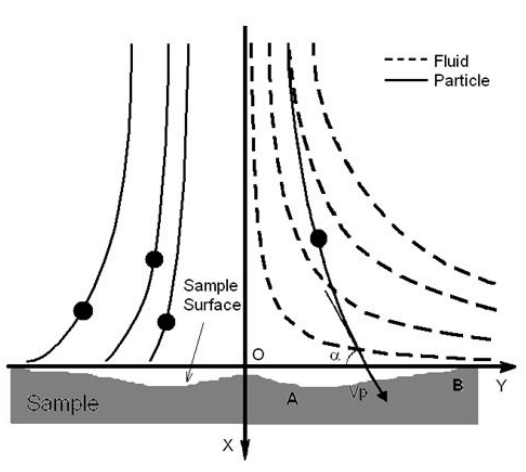
Figure 7. Scheme of a sample surface section during a normal impact, showing the scar where SEM images of figure 5 were taken: (A) at the location of maximum erosion depth within the scar and (B) outside the scar region. Adapted from 18 .